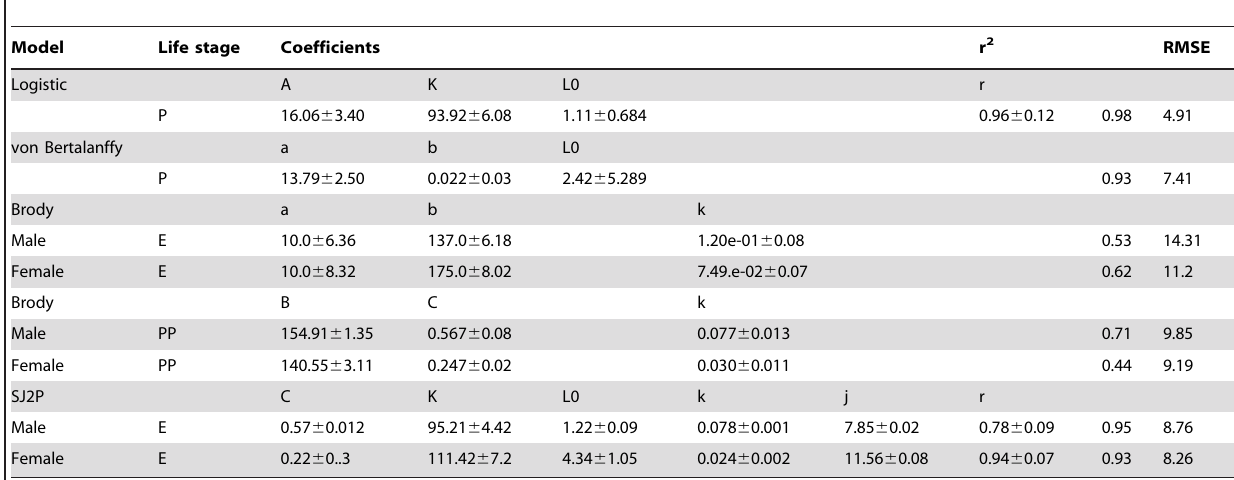
Parameter A is the value of the lower asymptote of the pes length growth curve, L 0 is the body measurement at birth (age=0), K is the asymptotic pes length in mm and r is the intrinsic growth rate. Parameter a is the parameter predicting asymptotic pes length and b is the maturation rate. Coefficients of the Brody model describe pes length growth after pouch vacation of pademelons. Parameter B is the mature (or asymptotic) pes length, C is an adjustment parameter when L0 ? 0 or t ? 0 , and k is the maturing rate index representing the ratio of maximum growth rate to mature size. For life stage, P indicates a model that describes the pouch life stage, E represents the model that describes the entire life growth and PP represents the model that describes the post-pouch life stage. Goodness of fit is given by r 2 : r-square value of the regression, and RMSE is the root mean square error. SJ2P is the smooth-joining two phase model.